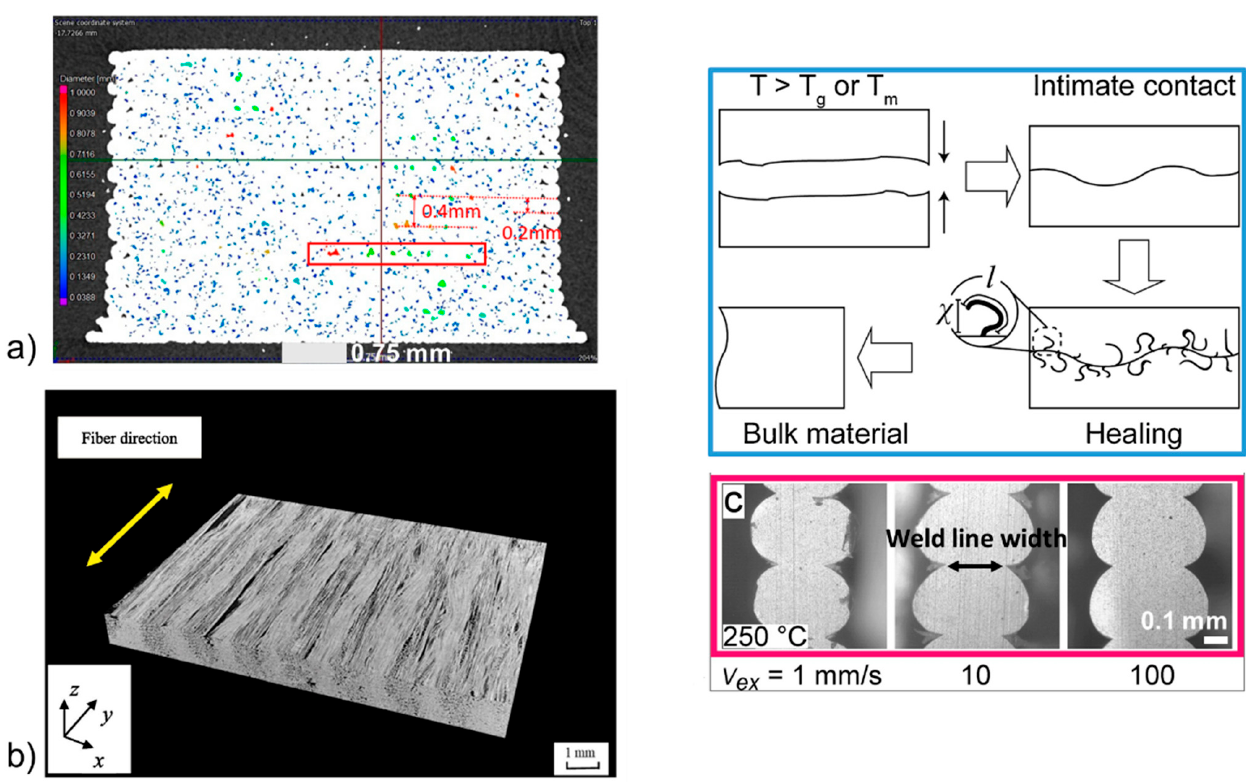
Figure 3. Visualization of interfaces in 3D printed materials: ( a ) mesoscale interfaces between printing lines in neat PLA by µCT analysis [17], ( b ) microscale interfaces resulting from fiber bundle-matrix debonding in continuous carbon fiber-reinforced PA observed by µCT [18] (copyright (2020), with permission from Elsevier), and ( c ) nanoscale interfaces in neat acrylonitrile butadiene styrene (ABS) observed by optical microscopy from thin sample slices, including the principle of this interface formation [24,27] (copyright (2017) and (2019), with permission from Elsevier).